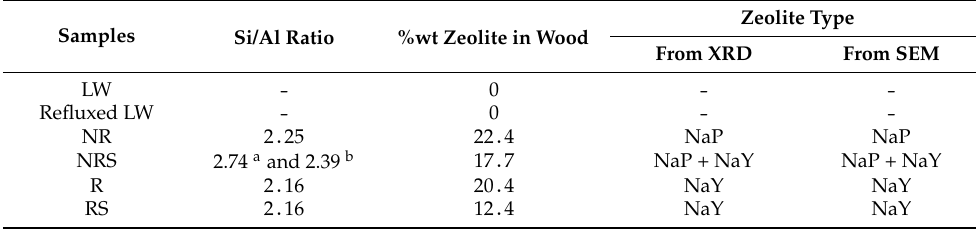
Table 1. Si/Al ratio from SEM-EDS, weight percent of zeolite per 100 g of composite from TGA and types of zeolites from XRD and SEM.